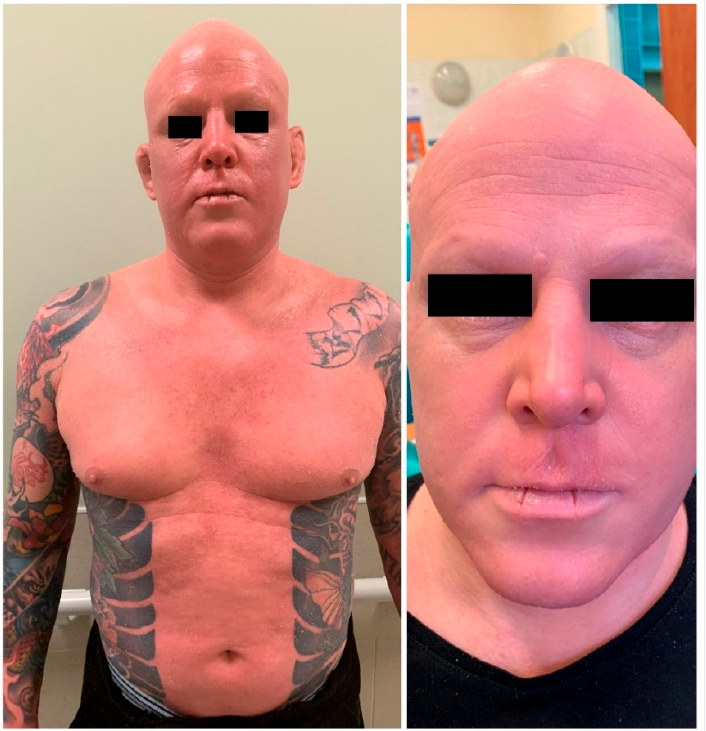
Figure 1. Systemic erythroderma, skin dryness and discoloration, loss of skin appendages (hair and sebaceous glands) on patient presentation in plastic surgery out-patient clinic.